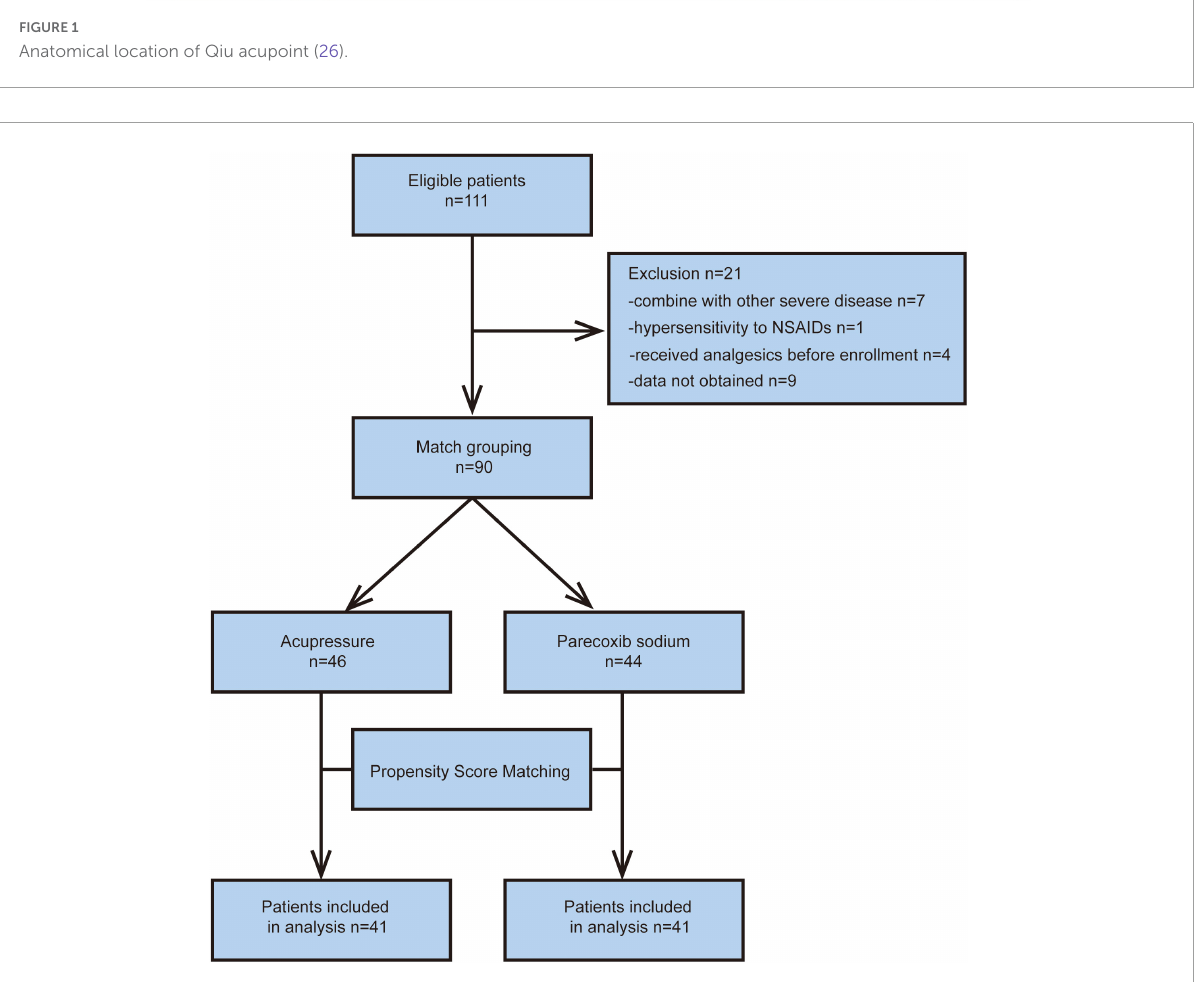
FIGURE2 Flow chart of the